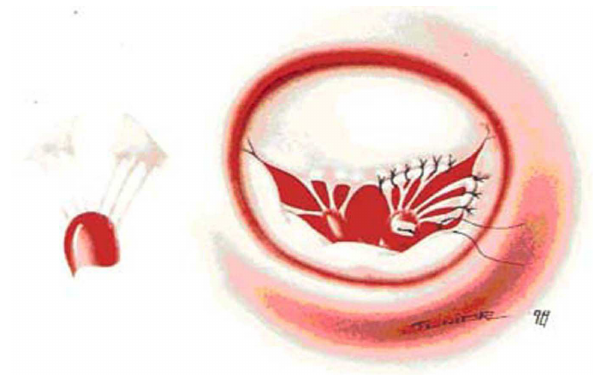
Fig. 5 – The graft sectioned in the middle remaining with two heads linked to the papillary muscle by a good number of chordae. One head is sutured to the anterior leaflet and the other head to the posterior on